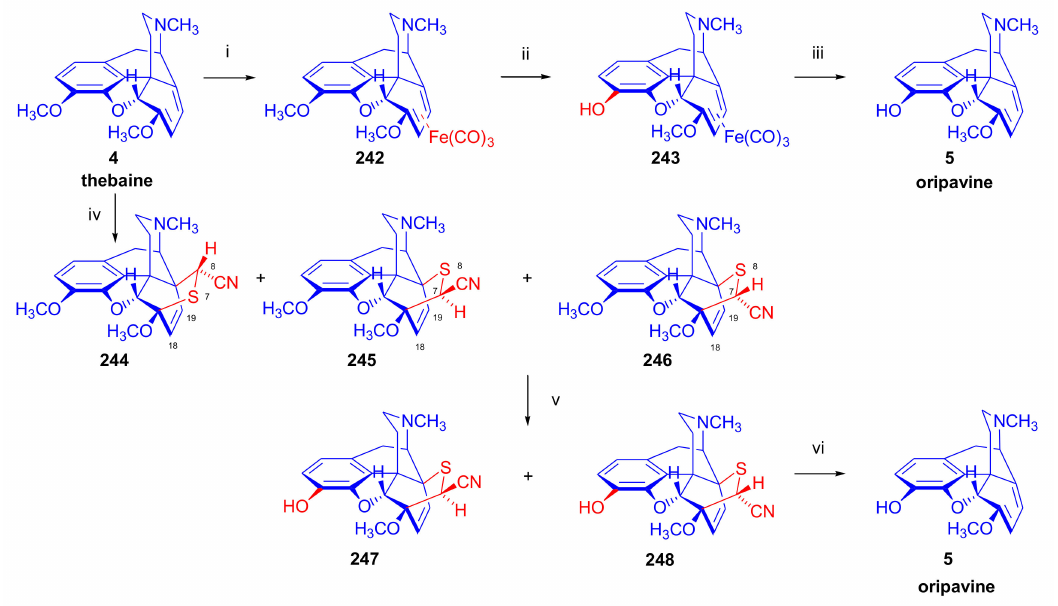
Figure 68. Conversion of thebaine to oripavine. Reagents and conditions : (i): iron pentacarbonyl, benzene, UV reactor, 40 ◦ C, 48 h, 95%; (ii): 3- O -demethylation ( method A–D : ( A ): BBr 3 , CH 2 Cl 2 , 0 ◦ C, 20 min to room temperature, argon, 15 min, 83%; ( B ): BF 3 · SMe 2 , CH 2 Cl 2 , 0 ◦ C, 4 h, room temperature, argon, 1.5 h, 83%; ( C ): MeSO 3 H, methionine, 50 ◦ C, 28 h, 67%; ( D ): 1M 9-I-9-BBN in hexane, room temperature, 2 h, 70%; (iii): UV irradiation, acetonitrile, 40 ◦ C, argon, 2.5 h, 35%; (iv):